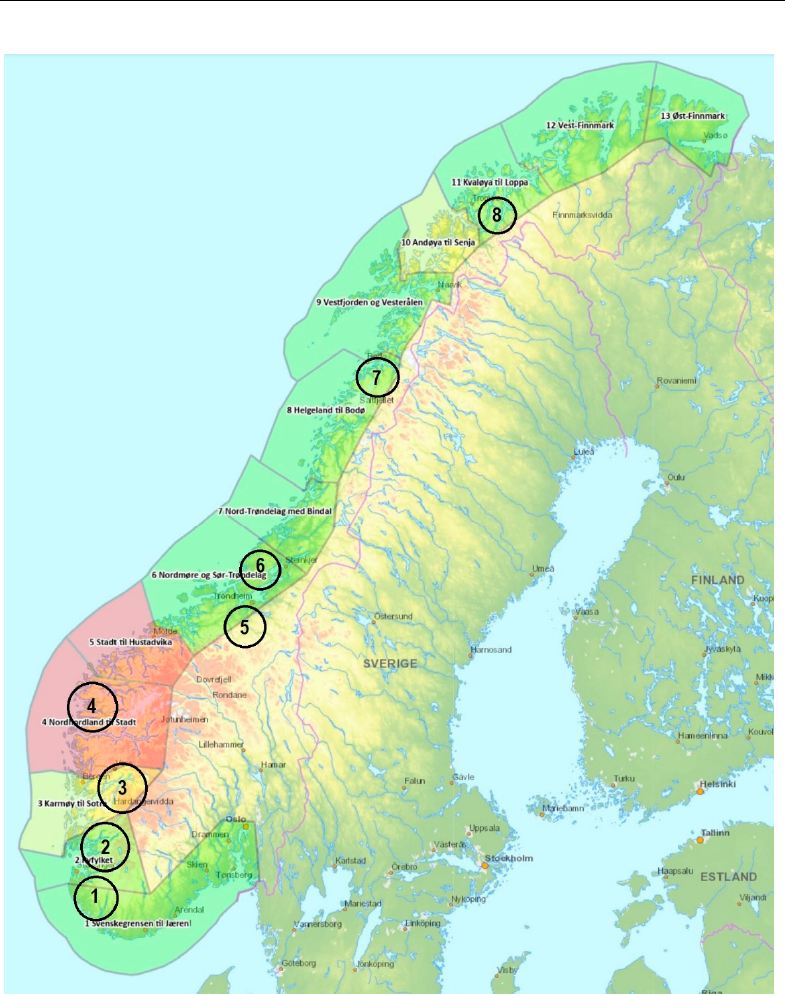
Figure 1. The eight smaller river regions (black circles 1–8) studied in the present study. The 13 larger production zones established for regulating farmed salmon production in Norway [29] are denoted with small numbers and names. The basic map with production areas is copied from the Norwegian Directorate of Fisheries’ website: https://www.fiskeridir.no/Akvakultur (accessed on 1 June